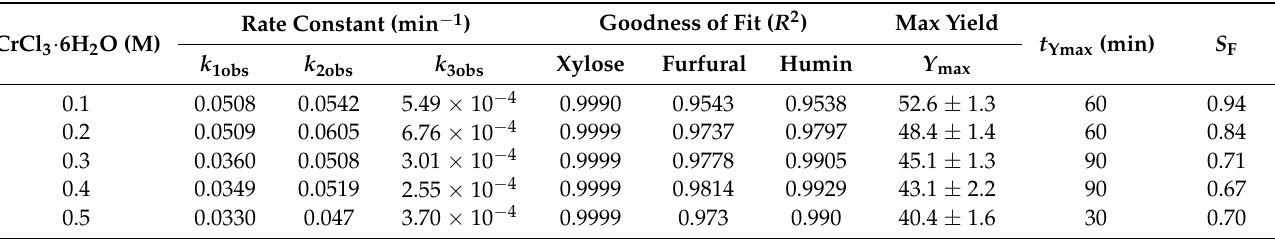
Table 3. Fitted reaction constant for xylose conversion into furfural in DMSO. Reaction conditions: 0.5 M xylose, 1.0 M p TSA, and 0.1–0.5 M CrCl 3 · 6H 2 O catalyst in 50 mL DMSO and stirring at 200 rpm, with reaction temperature of 120 ◦ C for 5